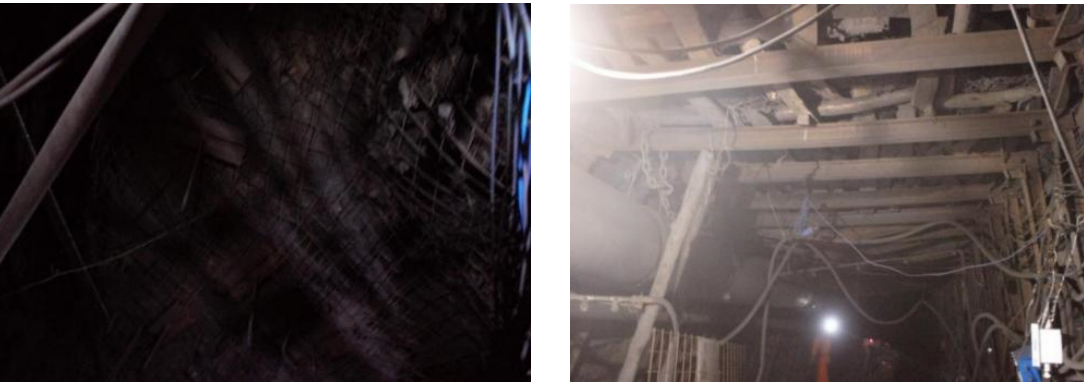
Figure 4. Deformation of surrounding rock during roadway excavation.